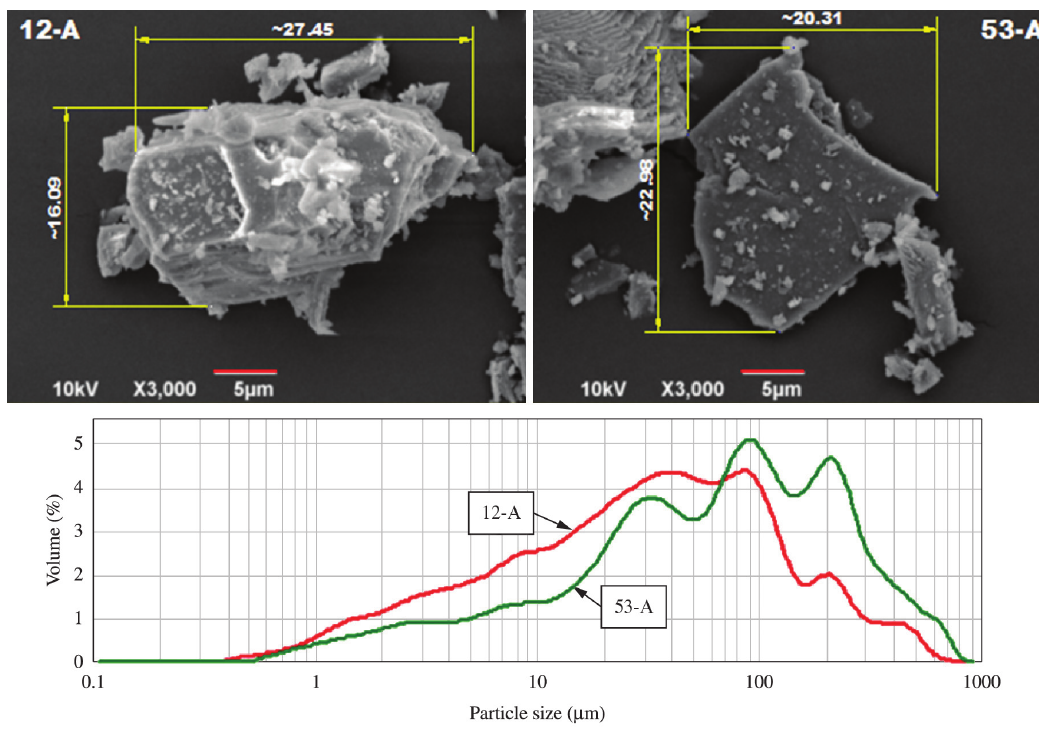
Figure 3. Particle size distribution after sieving.